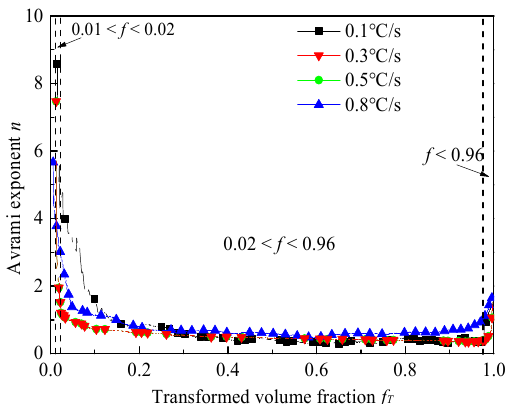
Figure 7. Relationship curves between Avrami exponent n and transformed volume fraction f T at different heating rates.